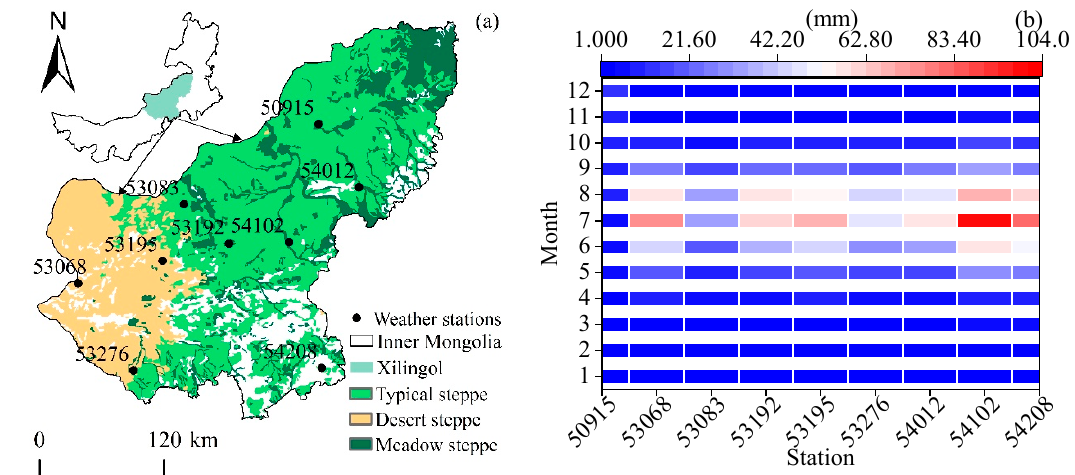
Figure 1. ( a ) Map of the study area of the Xilin Gol Region of China showing distribution of study area and meteorological stations. ( b ) Monthly rainfall changes at different stations from 1969 to 2018. (50915: Dong Ujimqin Banner, 53068: Erenhot, 53083: Naran-Bulag, 53192: Abag Banner, 53195: Sonid Left Banner, 53276: Zhurihe, 54012: Xi Ujimqin Banner, 54102: Xilin Hot, and 54208: Duolun).